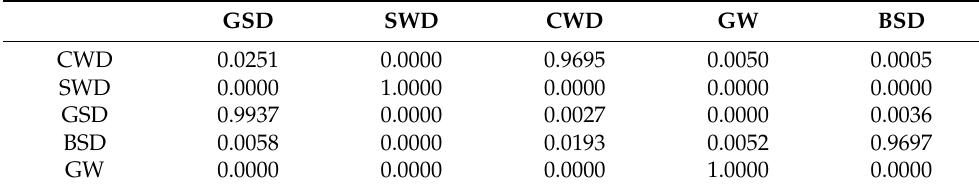
Figure 3. Fine-scale population structure based on stacked barplot of the cluster membership suggested by the Bayesian algorithm ( a ), first two discriminant functions of supervised DAPC analysis ( b ), the mutual nearest-neighbour graph obtained from unsupervised clustering method ( c ), and the first discriminant function of DAPC analysis ( d ). Table 4. The estimates of admixture proportion within